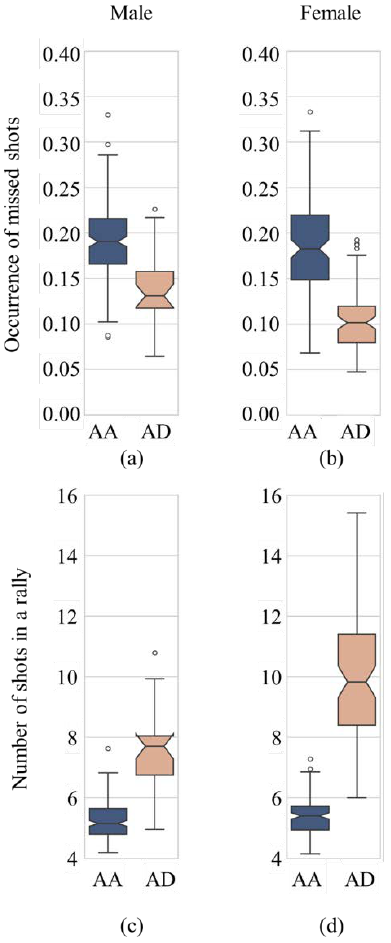
Figure 1 . Occurrence of missed shots and number of shots per rally by match category, “AA,” played by two offensive players, and “AD,” played by an offensive player and a defensive player. The box